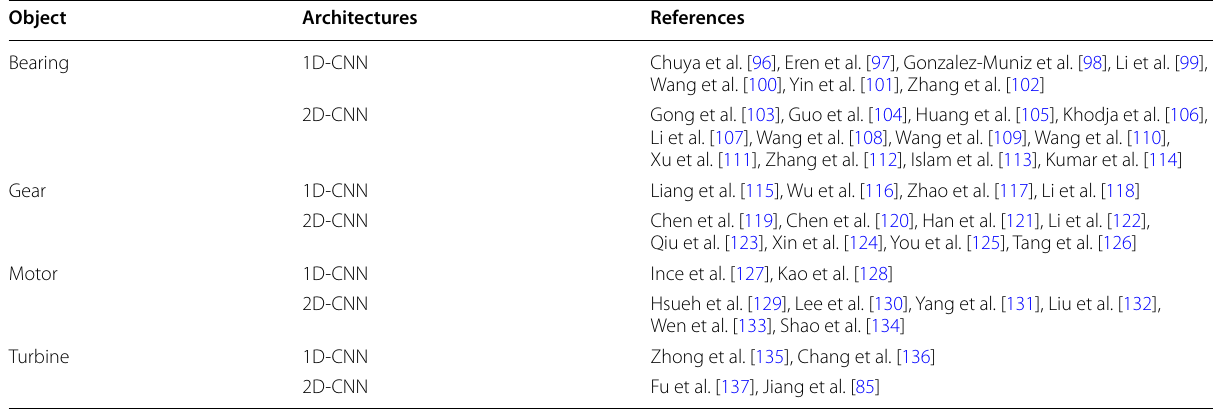
Table 2 Publications about the application of CNN in fault diagnosis Object